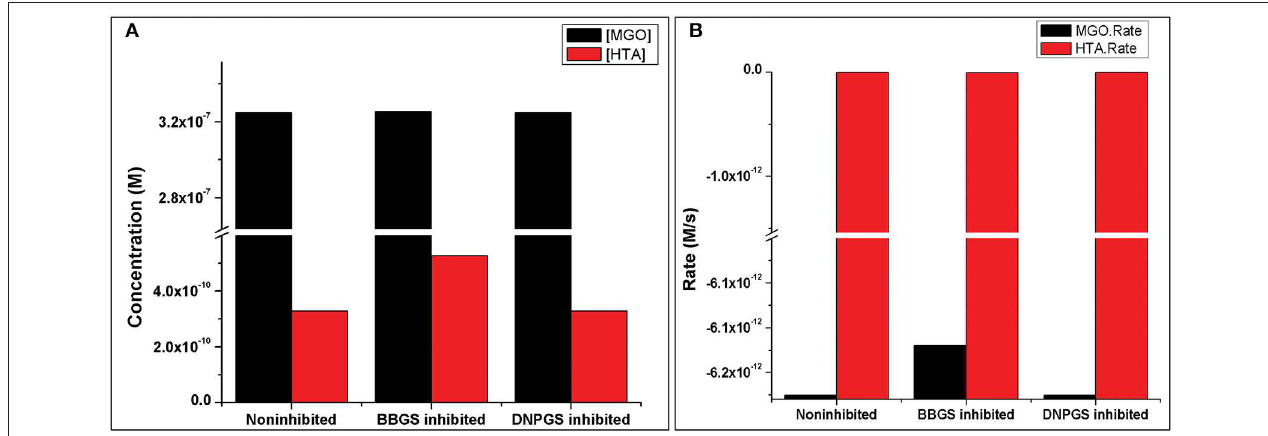
FIGURE 10 | Illustration of effect of two LmGLO I competitive inhibitors, BBGS and DNPGS on (A) MGO and HTA concentration, (B) on MGO and HTA formation rates. BBGS, S-4-bromobenzylglutathionylspermidine; DNPGS, S-2,4-dinitrophenylglutathionylspermidine.